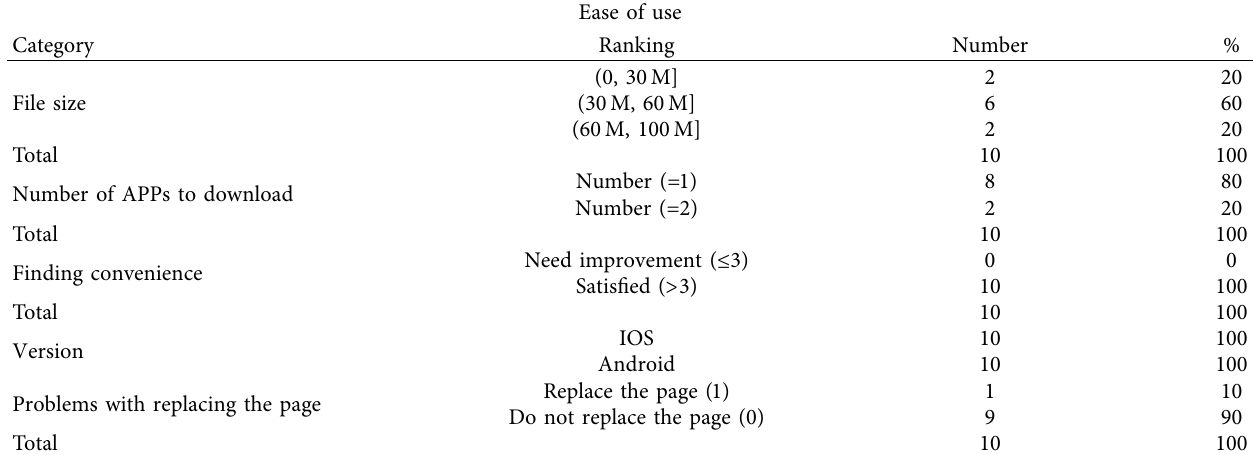
Table 6: Summary of the ease of use.